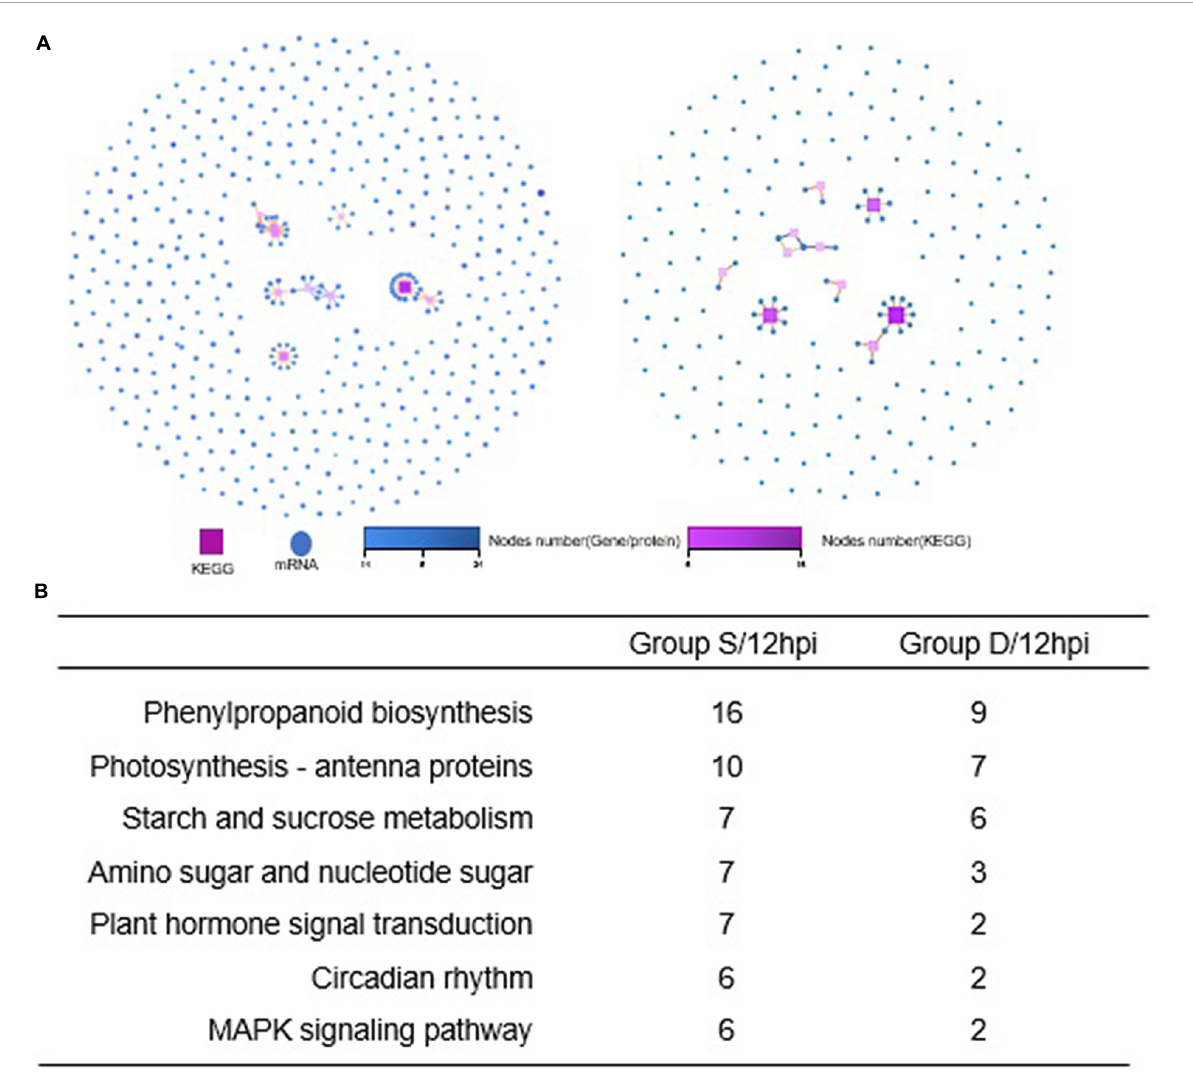
FIGURE5 KEGG pathway relationship network analysis and same nodes comparison between experimental groups at 12hpi. (A) The KEGG pathways of the selected genes are ranked by the number of genes on the pathway, and the top 10 pathways with the most significant number of genes were displayed in Group S (left) and Group D (right), respectively. Different shapes represent different content (nodes); the box represents KEGG Pathway, and the circle represents mRNA. Both color and size indicate the number of genes or transcripts connected to the node. The darker the color, the size of the box, the line with a different color represents the different path classification, and red represents cellular processes. (B) The nodes gene between groups S and D at 12hpi in KEGG pathway relationship